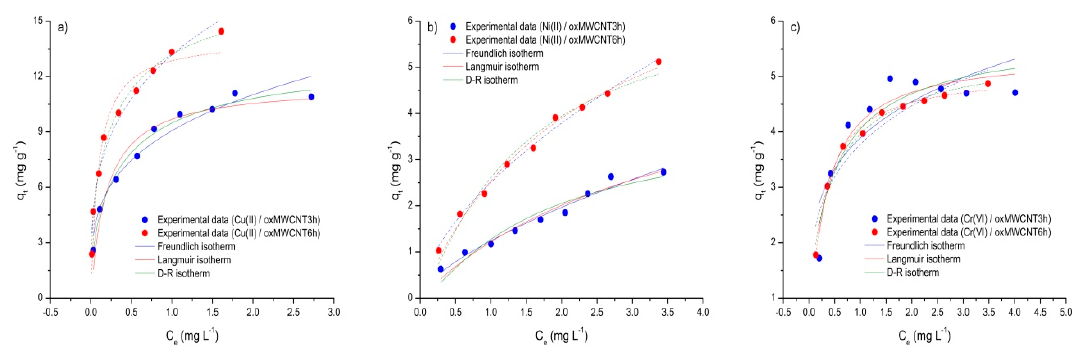
Figure 6. Non-linear regressions of experimental isotherms, obtained using Freundlcih, Langmuir and D–R models for: ( a ) Cu(II), ( b ) Ni(II) and ( c ) Cr(VI) adsorption on oxMWCNT3h and oxMWCNT6h ( m = 5 mg, V = 30 mL (0.1 M NaNO 3 ), C 0 = 0.5–5 mg L − 1 ,pH = 5 ± 0.1 (Cu(II) and Ni(II)) and 2.5 ± 0.1 (Cr(VI)), t = 24 h (Cu(II) and Ni(II)) and 96 h (Cr(VI)), agitation speed = 180 rpm, T = 298 ± 2 K). Table 5. Parameters of Freundlich, Langmuir and D–R models for the adsorption of ( a ) Cu(II), ( b ) Ni(II) and ( c ) Cr(VI) on oxMWCNT3h and oxMWCNT6h. oxFMWCNT3h oxFMWCNT6h Cu(II)